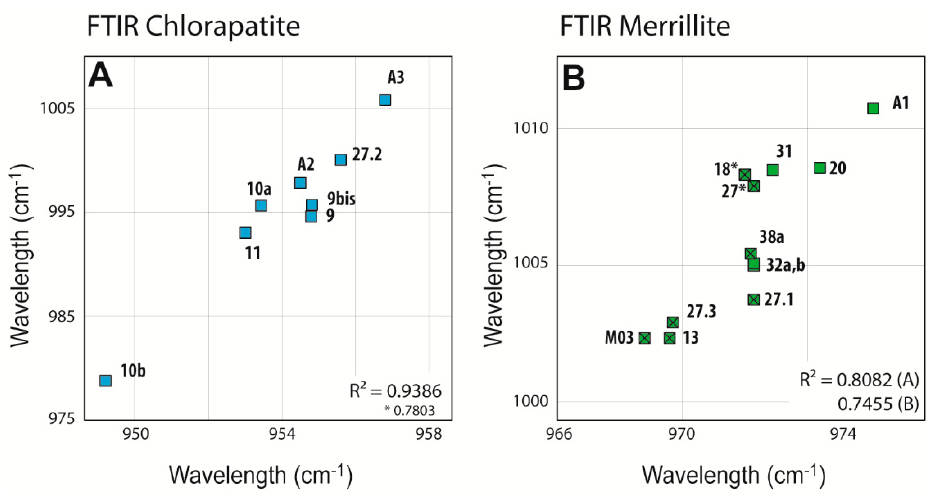
Figure 10. Bivariate diagrams of main peak position in the FTIR spectra, with their correlation coefficients. ( A ) FTIR Chlorapatite peaks. ( B ) FTIR merrillite peaks for type-A FTIR spectra (blank squares) and type-B FTIR spectra (crossed-out squares), with their correlation coefficients.